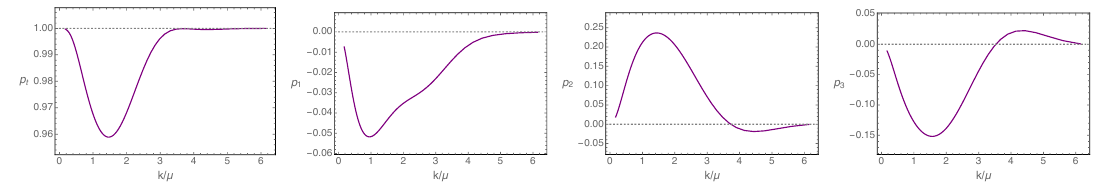
Figure 9 . The Kasner exponents as functions of k/µ at α b = 0 . 5 , T/µ = 0 . 5 . The gray dotted line is corresponding value of regular inner horizon of Reissner-Nordström black